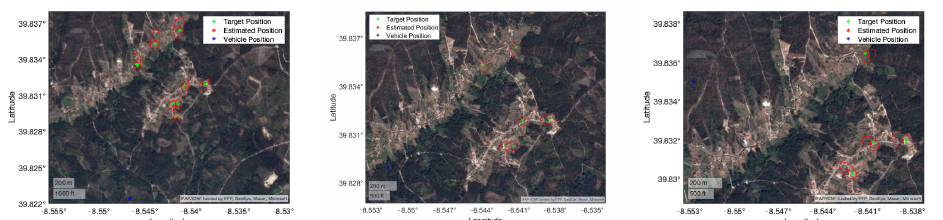
Figure 20. UAVision georeferencing results displayed on a satellite view of the terrain. The red marks and ellipses show, respectively, the IRT measurement and the estimated uncertainty computed by the UT in three sample frames of the